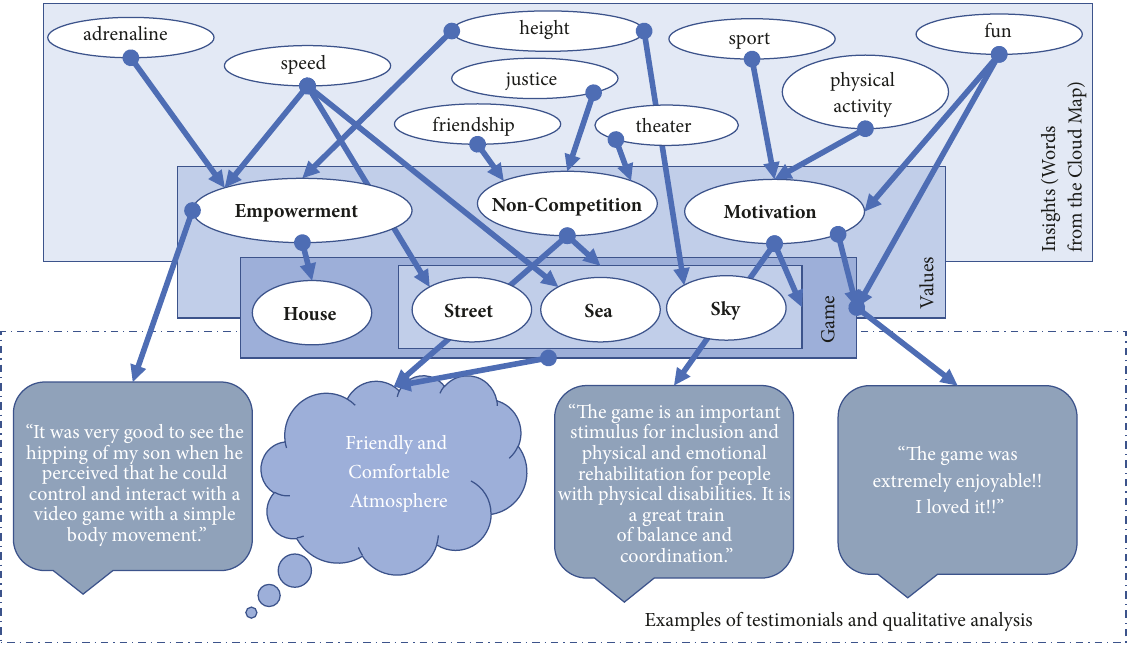
Figure 23: Visual analysis from the flow of insights that generated the game and its implication to the qualitative analysis of the game.